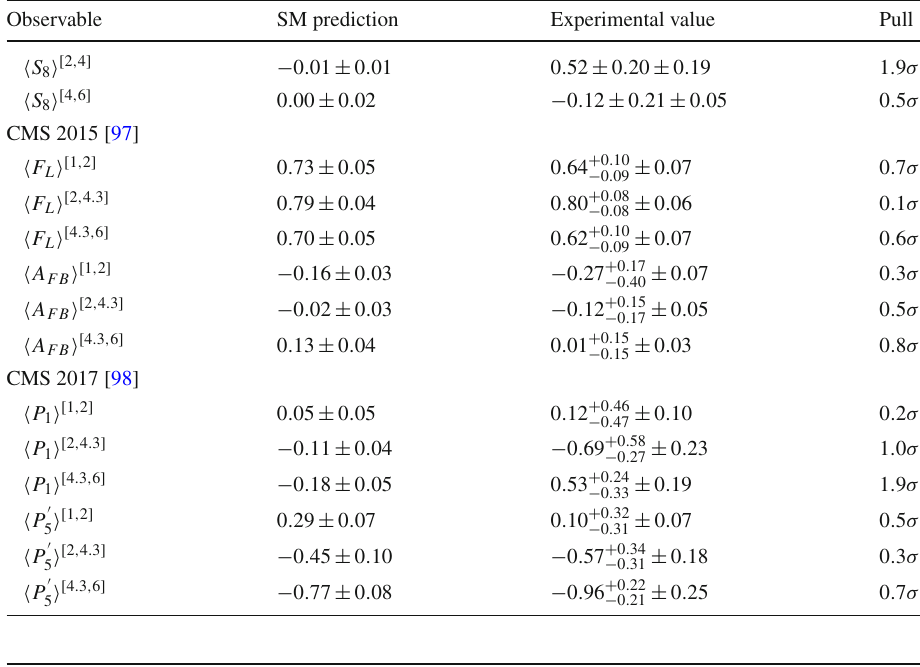
Table 9 Angular observables of B 0 → K ∗ 0 μ + μ − included in the global fit